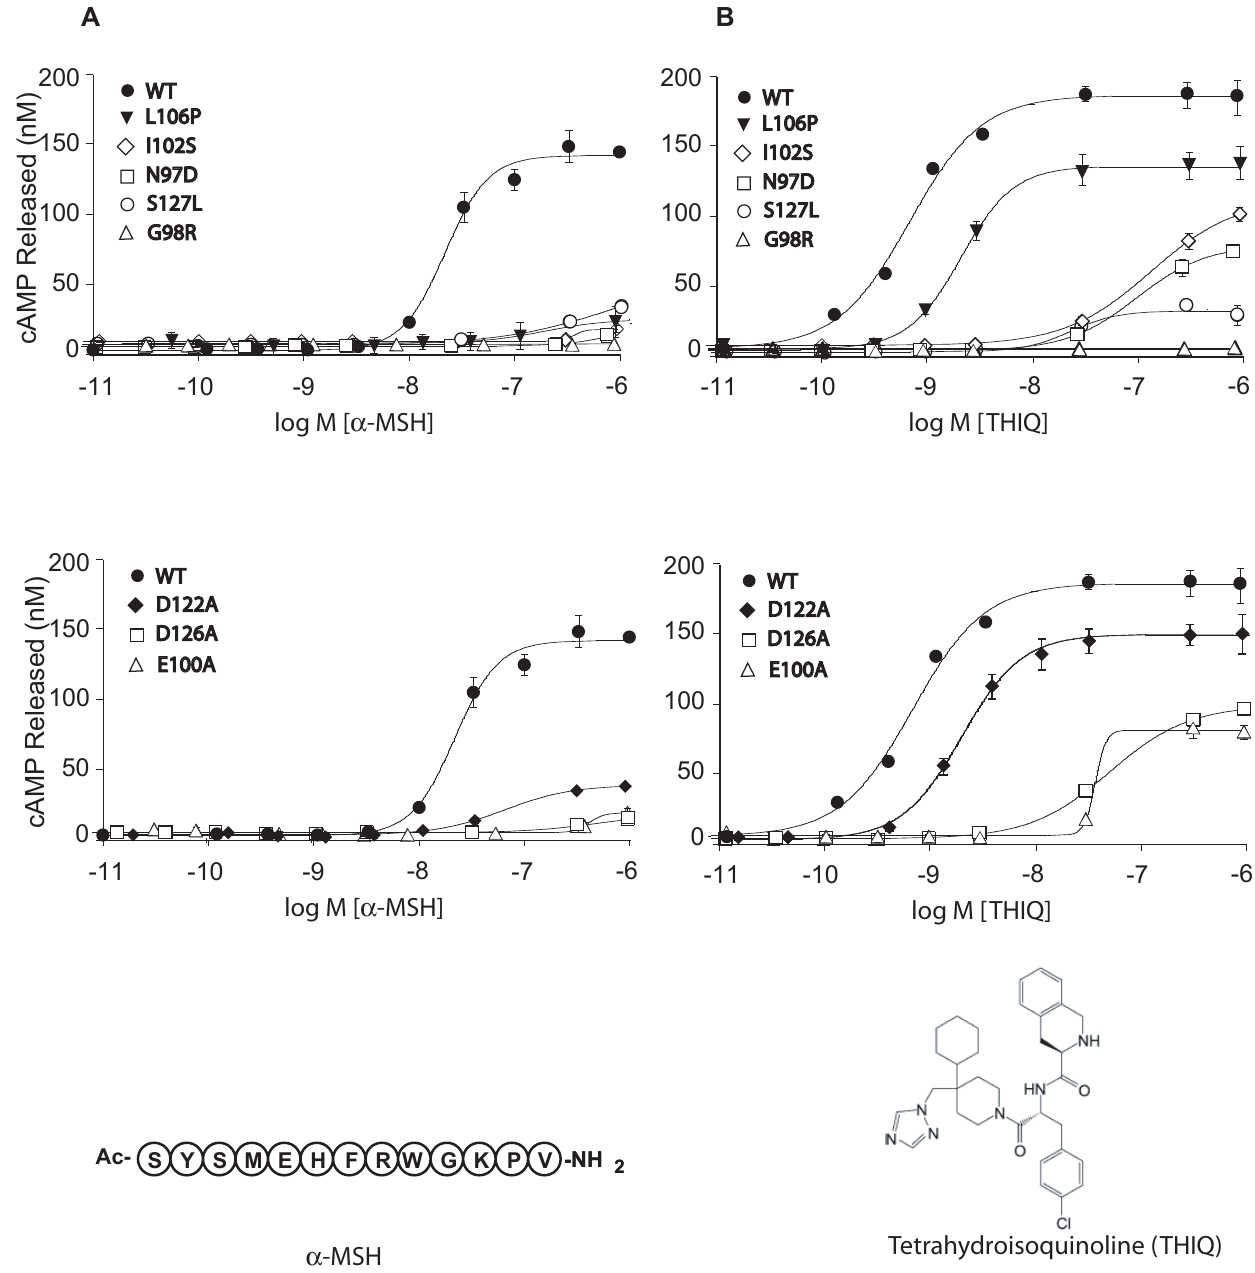
Figure 3. Wild-type (WT) and mutant MC4Rs were transiently transfected into HEK293 cells, which were stimulated with increasing concentrations of a -MSH (A)or of THIQ (B), and cAMP was measured to generate dose-response curves. Data shown are mean 6 s.e.m. of quadruplicate determinations. The dose-response curves are representative of at least three independent experiments. The amino acid sequence of a -MSH and the chemical structure THIQ are shown below panels A and B,